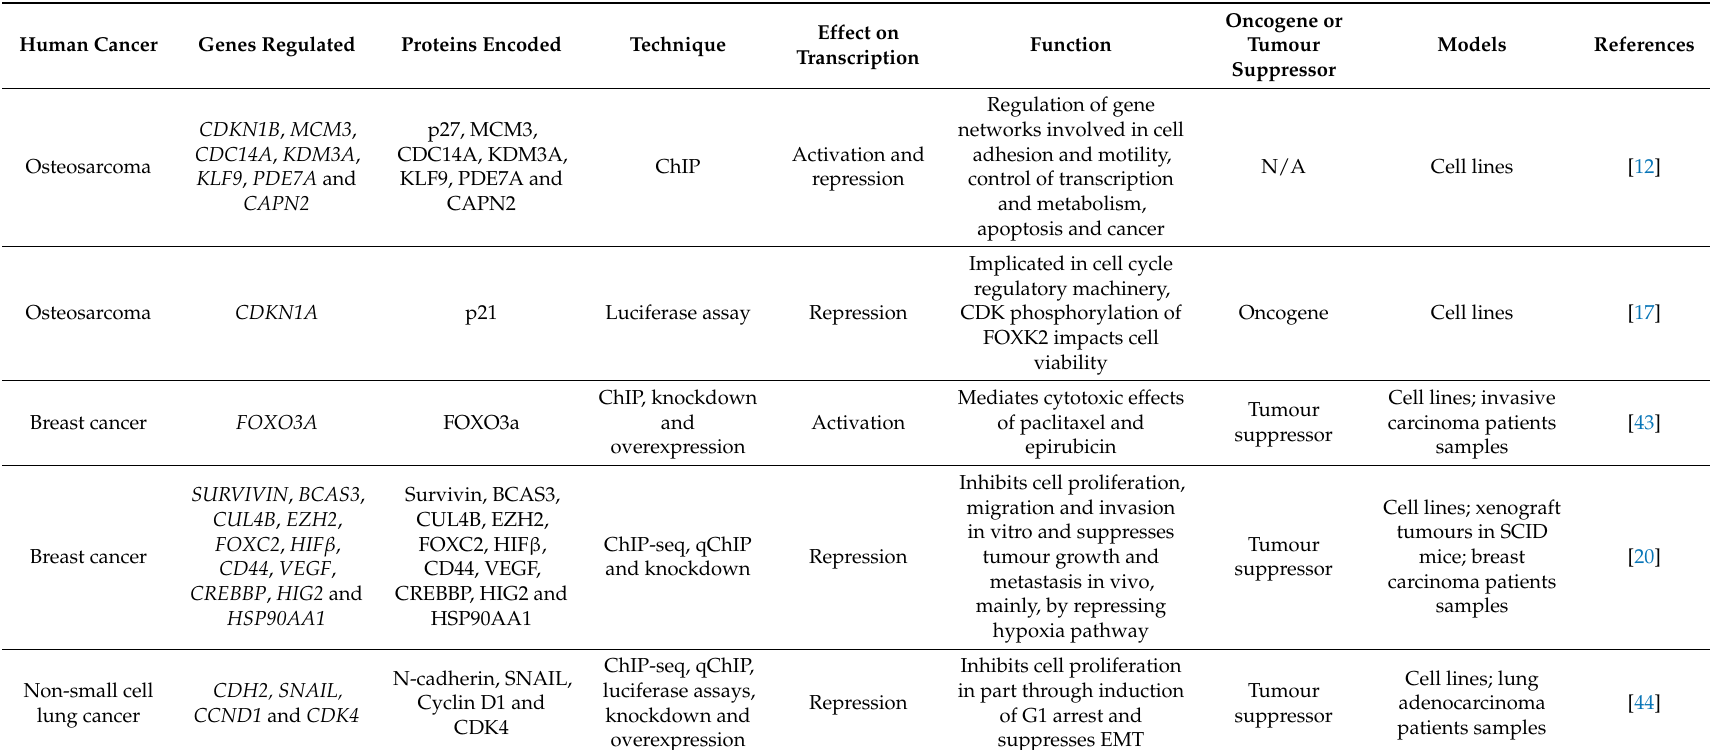
Table 2. Genes regulated by FOXK2 in cancer